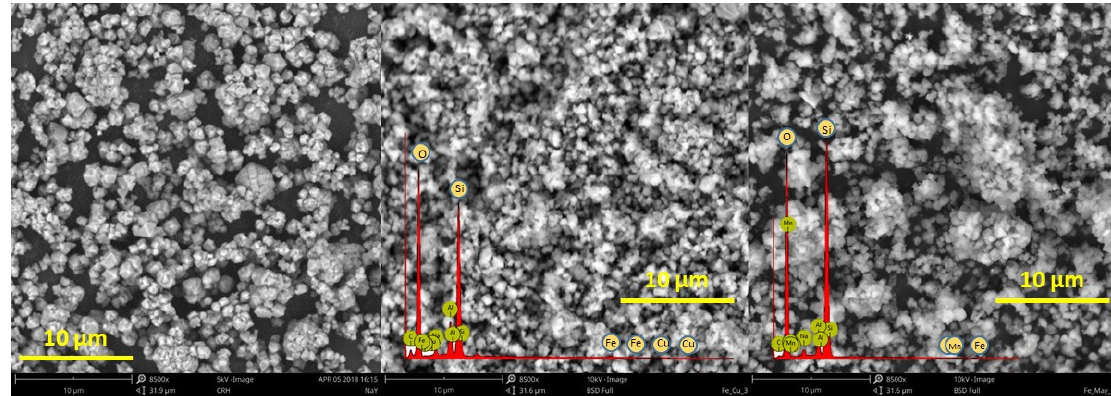
Figure 12. SEM micrographs of the parent zeolite NaY, FeCu-NaY and FeMn-NaY, respectively. EDX spectrum of the